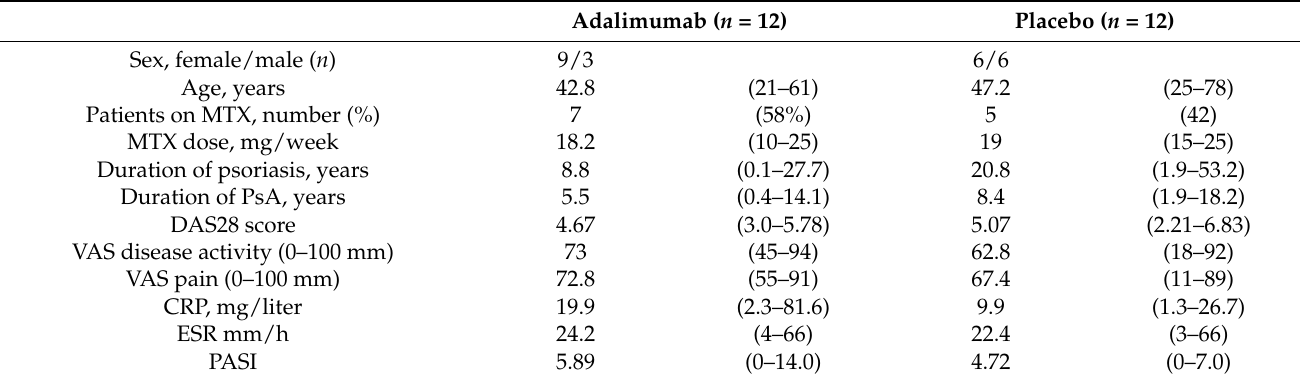
Table 1. Demographic and clinical characteristics at baseline of the 24 patients with psoriatic arthritis. Adalimumab ( n =